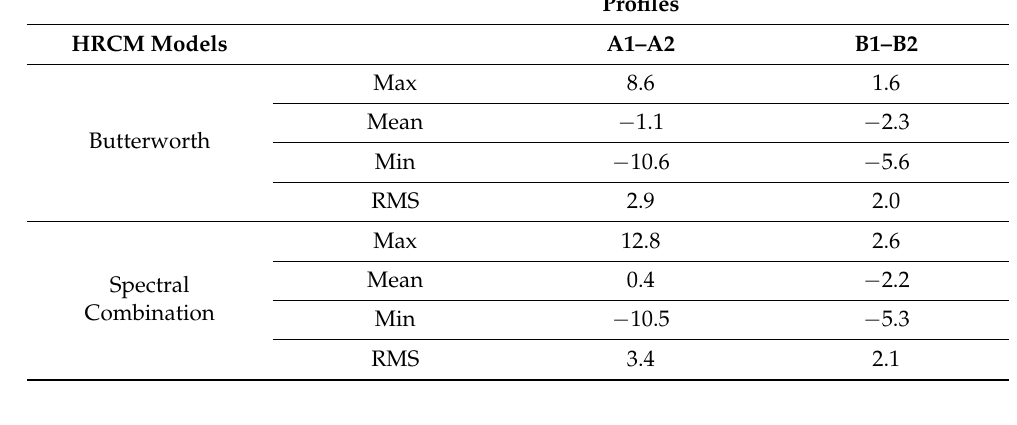
Table 4. Statistics of the HRCM Moho depth differences with respect to the point-wise seismic Fennoscandia Moho depth estimates [30] along the A1-A2 and B1-B2 profiles. Unit: km. Profiles